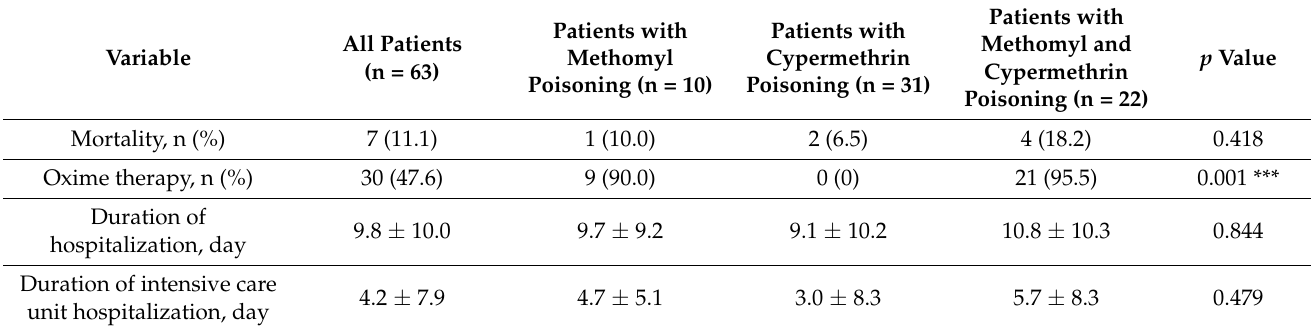
Table 4. Outcomes of patients with pesticide poisoning, stratified by type of pesticide (n = 63).